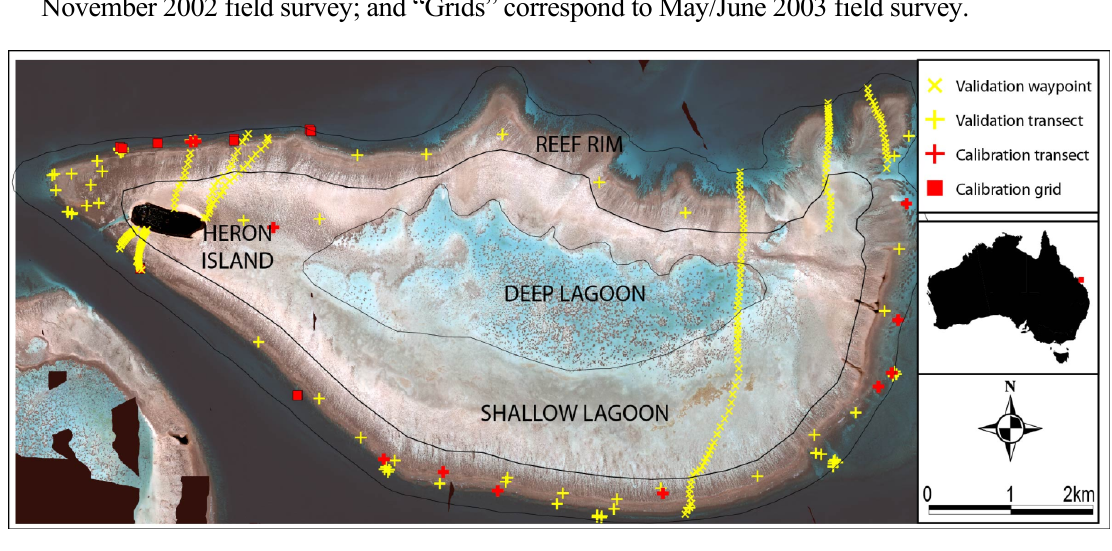
Figure 1. Heron Reef study site, southern Great Barrier Reef. All field data calibration (n = 22) and validation (n = 273) sites are shown. The geomorphic categories based on [37] are also outlined. “Waypoints” correspond to April 2001 field survey; “Transects” correspond to November 2002 field survey; and “Grids” correspond to May/June 2003 field